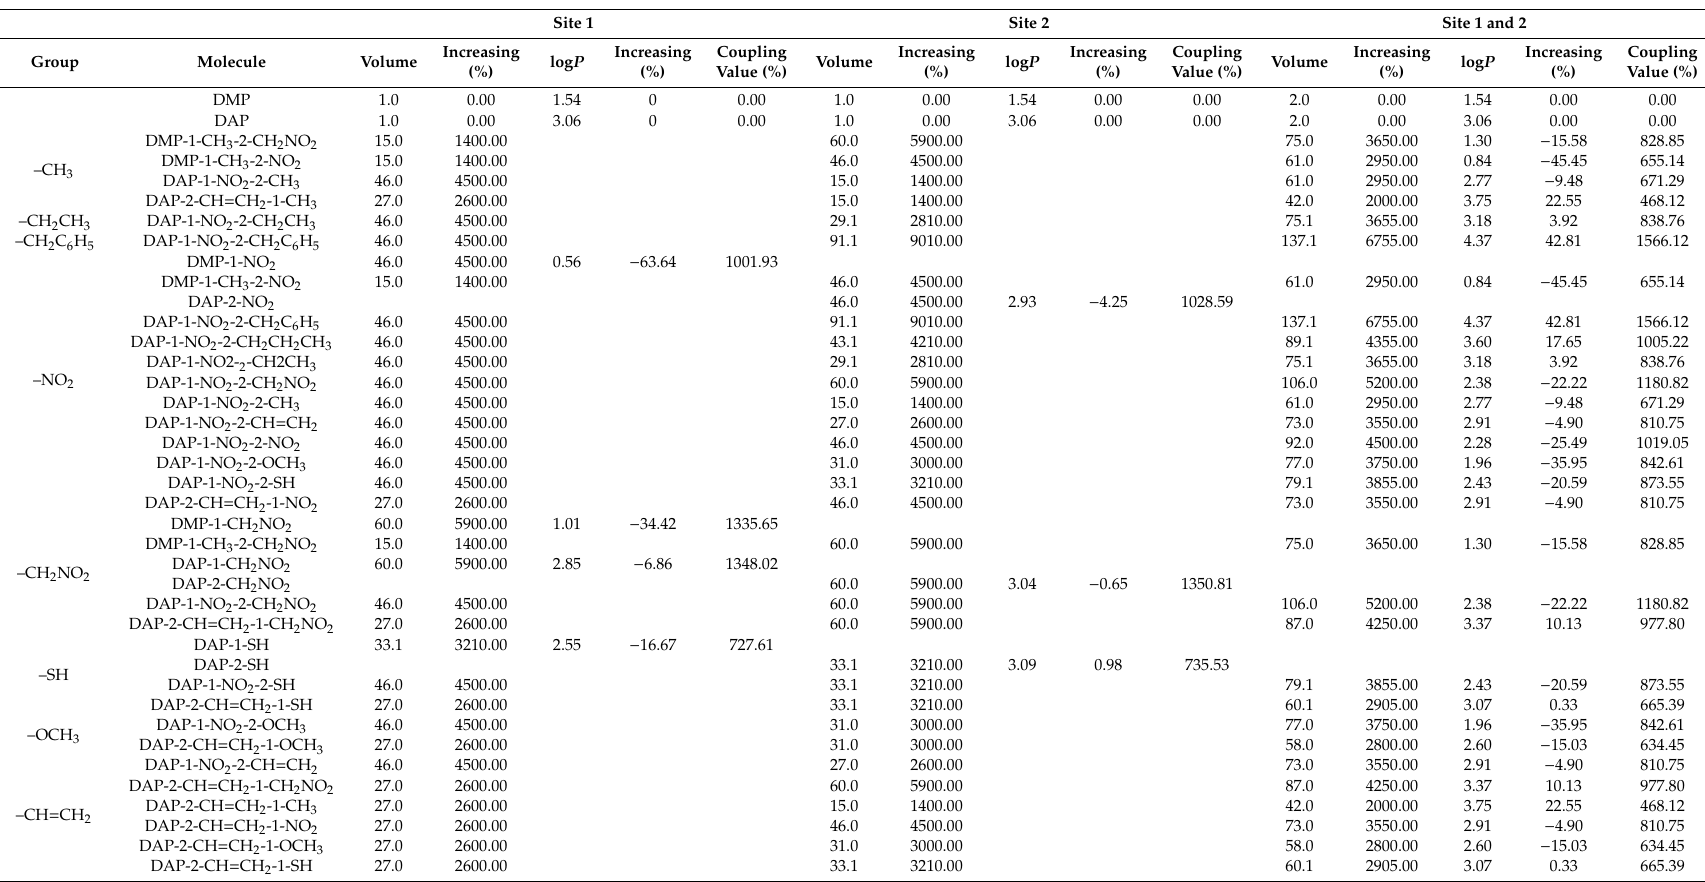
Table 9. Coupling values of the modified groups’ properties in PAE